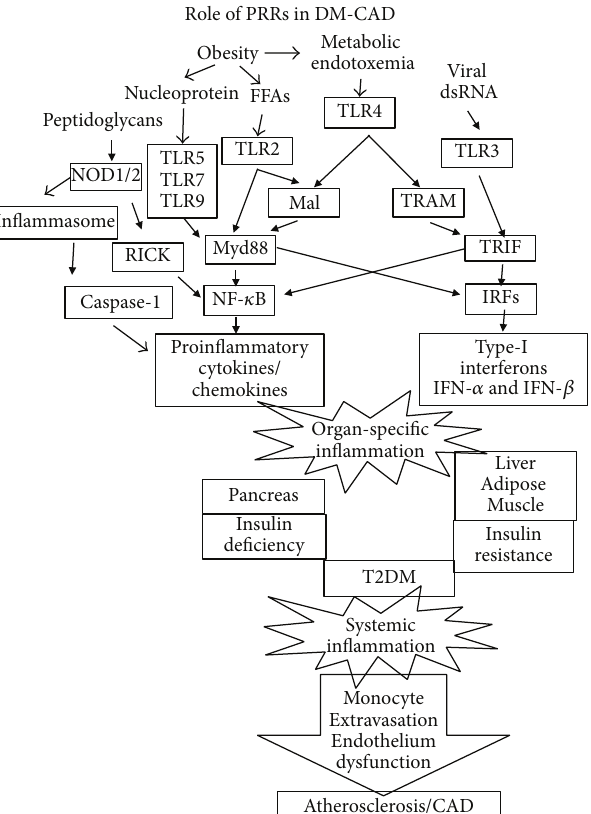
Figure 1: Role of innate immune responsein triggering metainflam- mation associated with DM-CAD. Pattern recognition receptors (PRRs) are the well characterized innate immune receptors which trigger metainflammation following recognition of both pathogen associated molecular patterns (PAMPs) and damage associated molecular patterns (DAMPs). Viral nucleic acids, endotoxins, and peptidoglycans are some of the PAMPS which are released into the circulation following metabolic endotoxemia. Free fatty acids and self-nucleoproteins are some of the endogenous ligands which act as DAMPs. The end result is the activation of NF- 𝜅 B and IRFs which in turn activate proinflammatory cytokines and type- 1 interferons, respectively. These inflammatory mediators destroy pancreatic beta cells leading to insulin deficiency and induce inflam- mation at insulin target organs leading to insulin resistance (IR) eventually precipitating in Type-2 Diabetes. Long standing diabetes induces systemic inflammation leading to monocyte activation and endothelial dysfunction leading to the extravasation of monocytes and formation of atherosclerotic